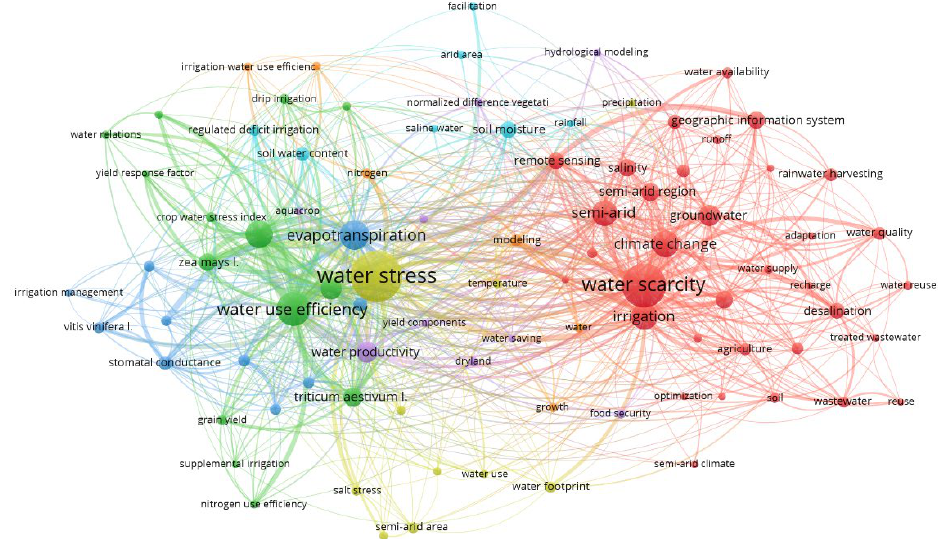
Figure 5. Network of co-occurrences of author keywords. Cluster 1 (red colour), cluster 2 (green colour), cluster 3 (blue colour), cluster 4 (yellow colour), cluster 5 (purple colour), cluster 6 (light blue colour), cluster 7 (orange colour).